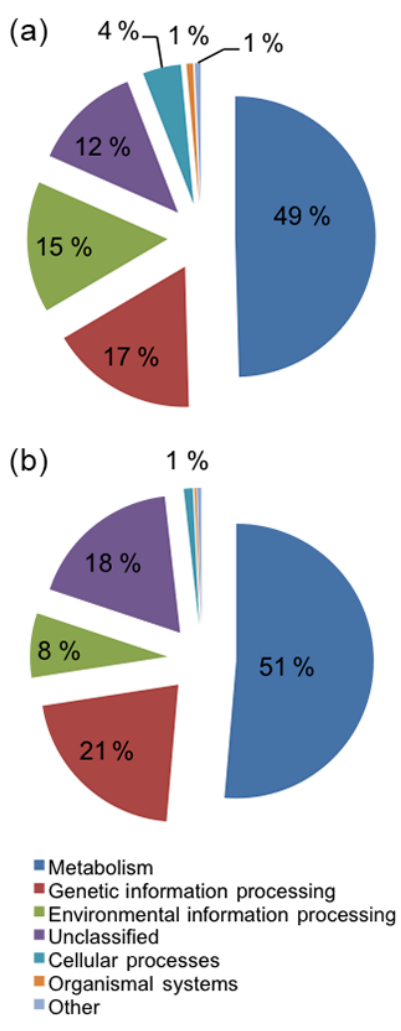
Figure 5. The average predicted functionality of all (a) bacterial and (b) archaeal metagenomes reconstructed from 16S rRNA gene